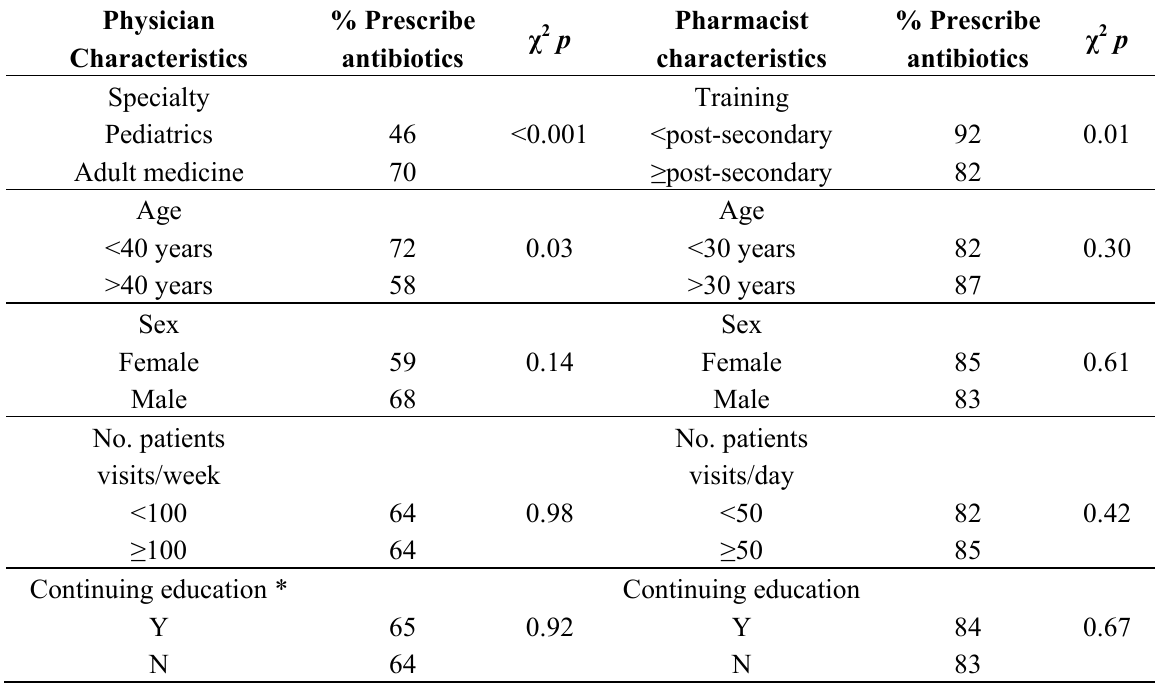
Table 4. Physician and pharmacist factors associated with self-reported antibiotic prescribing for colds.